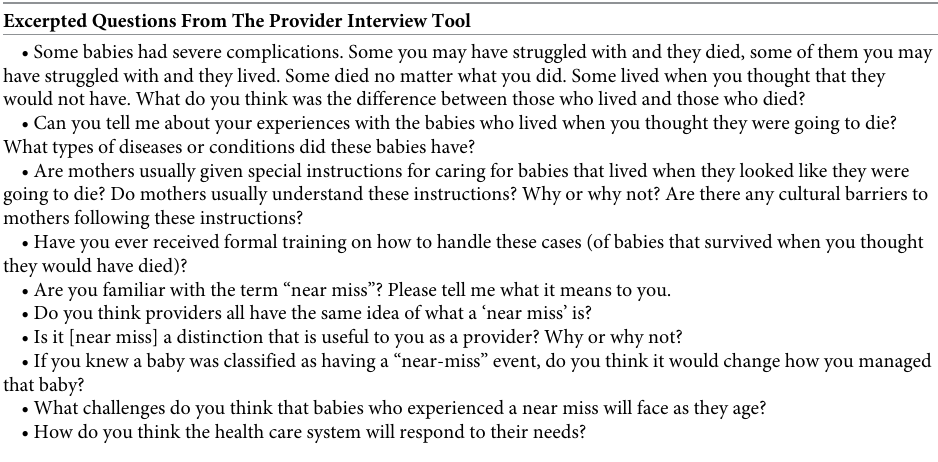
Table 1. Excerpts from the semi-structured interview tool used with providers. Excerpted Questions From The Provider Interview